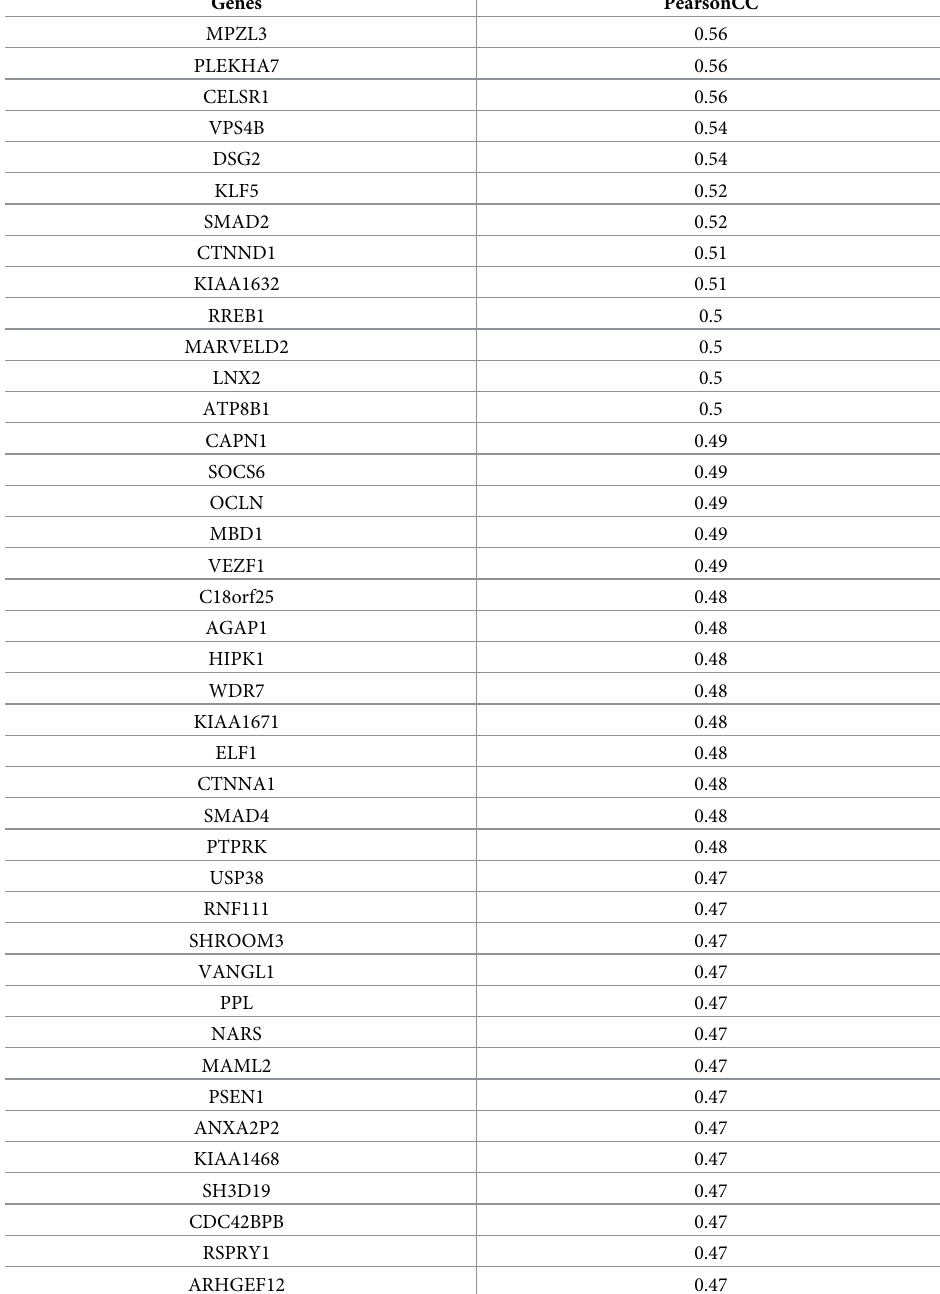
Table 1. Top 50 genes positively correlated with MYO5B in UCEC tumors.